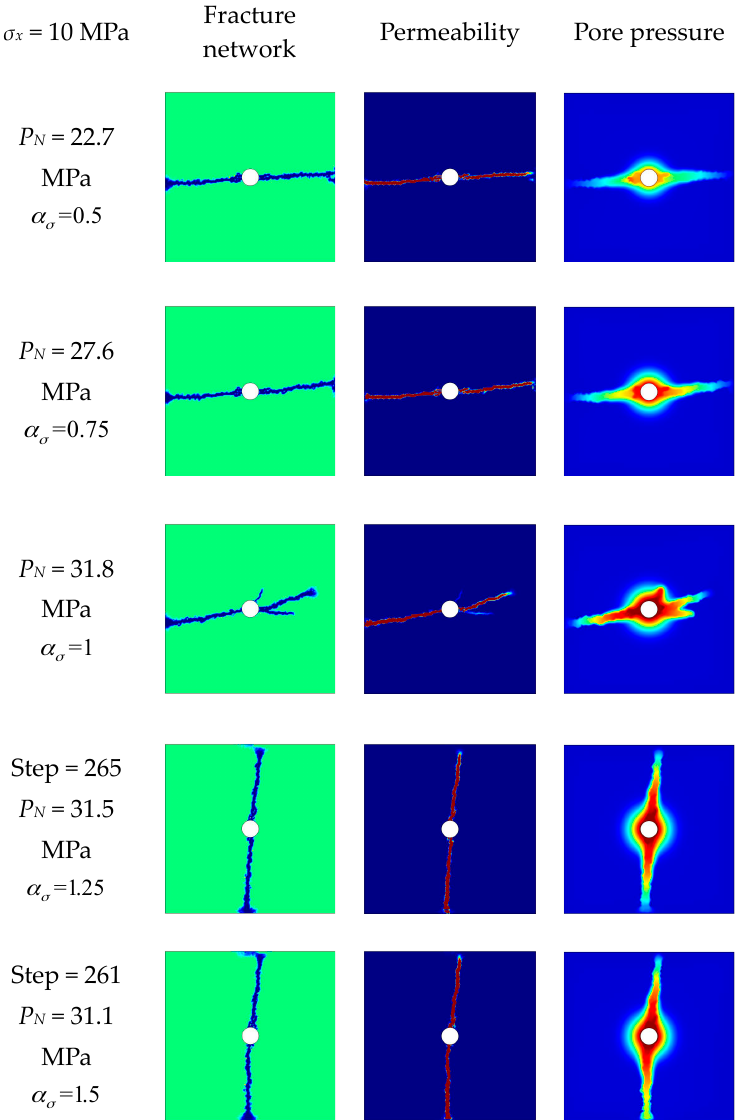
Figure 13. Fracture network evolution and related responses during the nitrogen fracturing under different stress ratios.